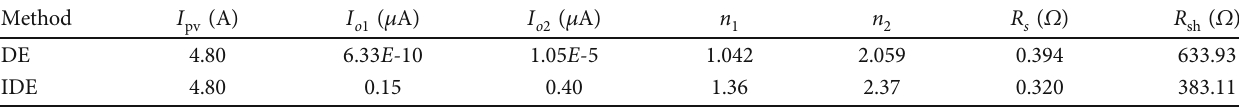
Table 3: Extraction parameters of SP75 module with di ff erent methods.